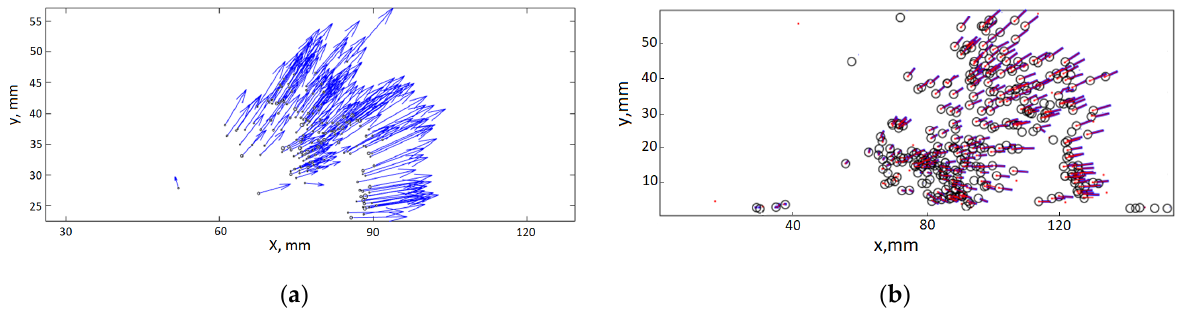
Figure 3. ( a ) Approximate velocity field obtained by PIV interpolated to position of each droplet (shown in circles)/( b ) An example of a trajectory evaluation. Circles shows the search area near the assumed position. Blue straights are the previous four points of each trajectory. Red dots show the positions of all droplets on the frame.